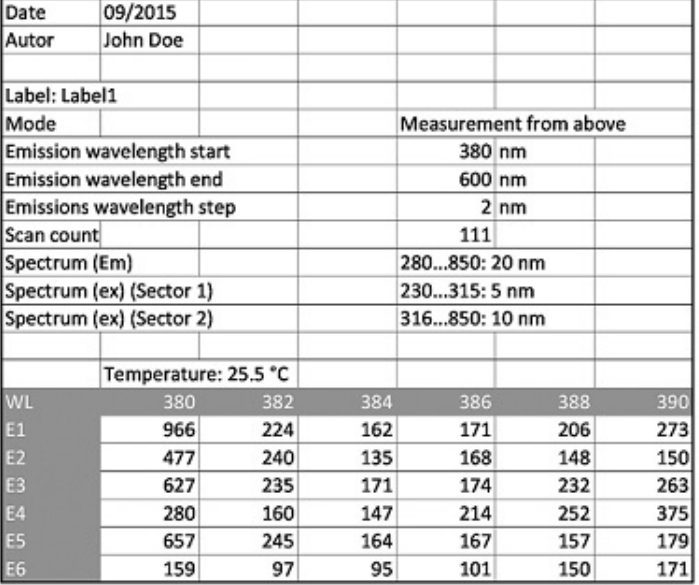
Figure 1. Spreadsheet Data Structure